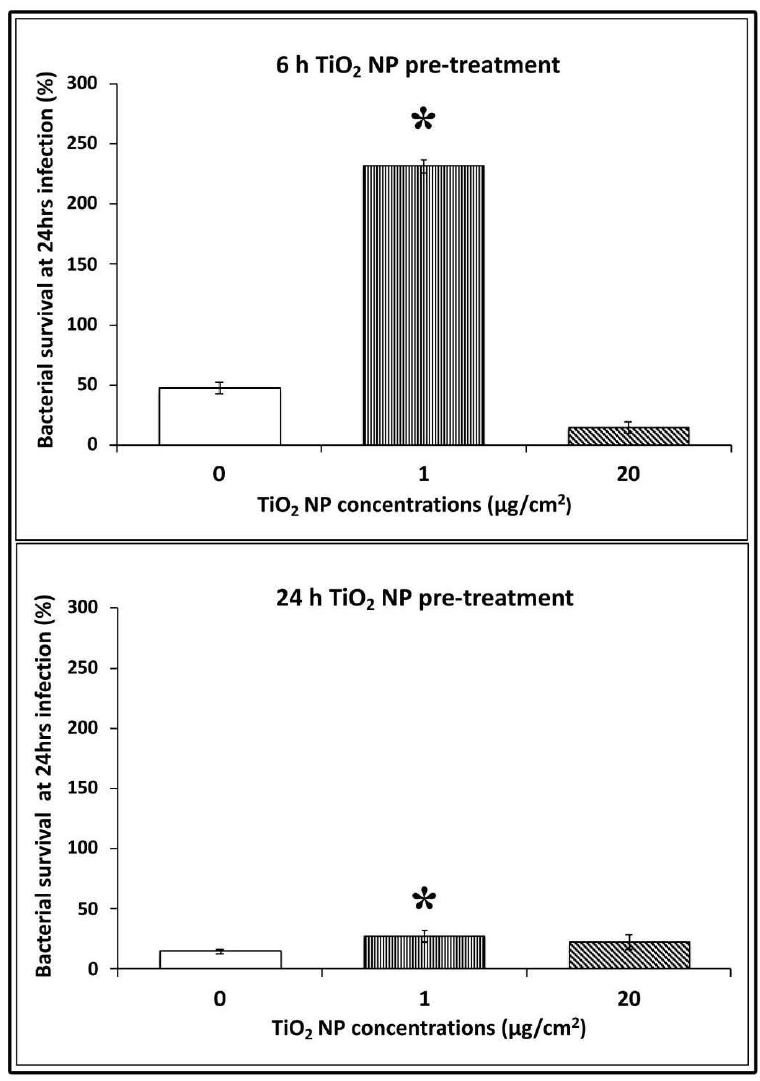
Figure 4. Bacterial survival after 24 h of infection in HT-29 cells pre-treated with TiO 2 NPs. Values corresponded to the number of CFU 24 h post-infection divided by the number of CFU 3 h post-infection. Data are presented as means ( ± standard deviation) of at least three experiments. Asterisks indicate statistically significant values compared to control untreated infected cells (* p <